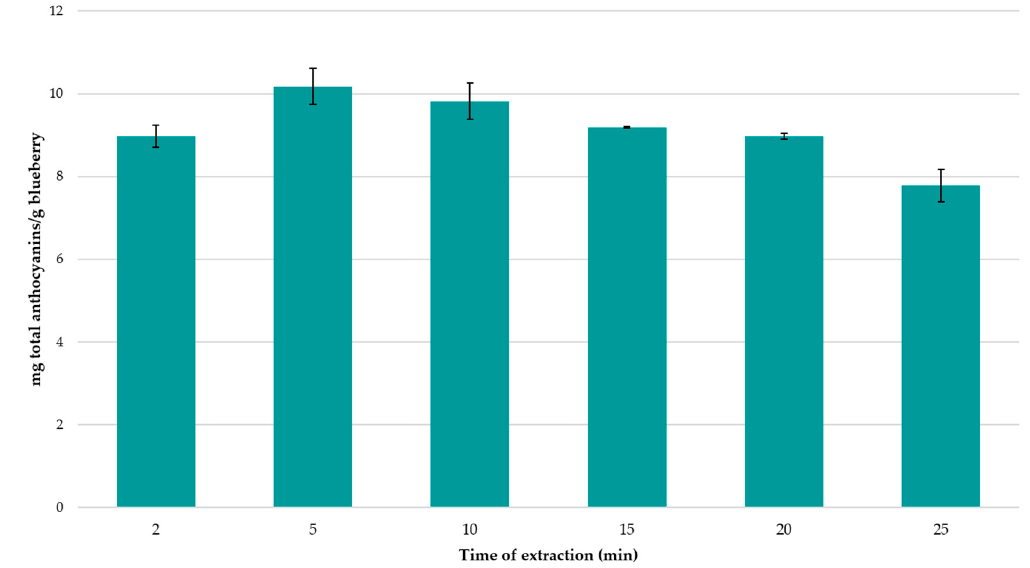
Figure 3. Study of the extraction time to optimize the recovery of anthocyanins from blueberry extracts ( n = 3). The error bars represent the uncertainty of the measurement in the three